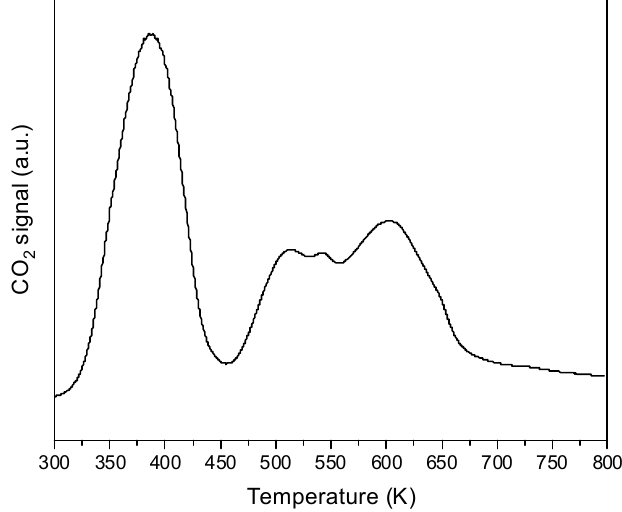
Figure 3. TPD diagram of CO 2 desorption from CeO 2 . The spectra of CeO 2 calcined at 570 K and above show a band at 2126 cm − 1 . The interpretation of the band was discussed by Binet et al. [31]. These authors proposed the electronic origin of this band, either an electronic transition from donor levels located near the conduction band, such as Ce 3+ or oxygen vacancies [36], or the forbidden 2 F 5/2 → 2 F 7 /2 electronic transition of Ce 3+- located at the subsurface or bulk defective lattice sites [37]. 2.2. Reaction of Ethanol with CeO 2 The interaction of ethanol with the surface of CeO 2 is chemisorption. The reaction of ethanol on the CeO 2 surface produces ethoxy groups. In order to follow the properties and reactivity of ethoxy groups, the doses of ethanol were adsorbed, and subsequently, non- reacted ethanol was removed by evacuation at 370 K. The results presented in Figure 4 evidence that the evacuation at 370 K was sufficient to remove unreacted ethanol—the δ OH band of the deformation vibrations of molecular ethanol at 1270 cm − 1 disappeared upon the evacuation at this temperature. The spectra recorded upon the adsorption of several doses of ethanol on CeO 2 activated at 570 K are presented in Figures 5A and B. The bands at the regions 850–950 cm − 1 and 1000–1080 cm − 1 are assigned to the symmetric and asymmetric vibrations of C- C-O fragments, respectively. The bands in the 1080–1150 cm − 1 region may be assigned to combination vibrations δ M-O-C + r ║ CH3 [28]. In each of these regions, three narrow maxima are seen.